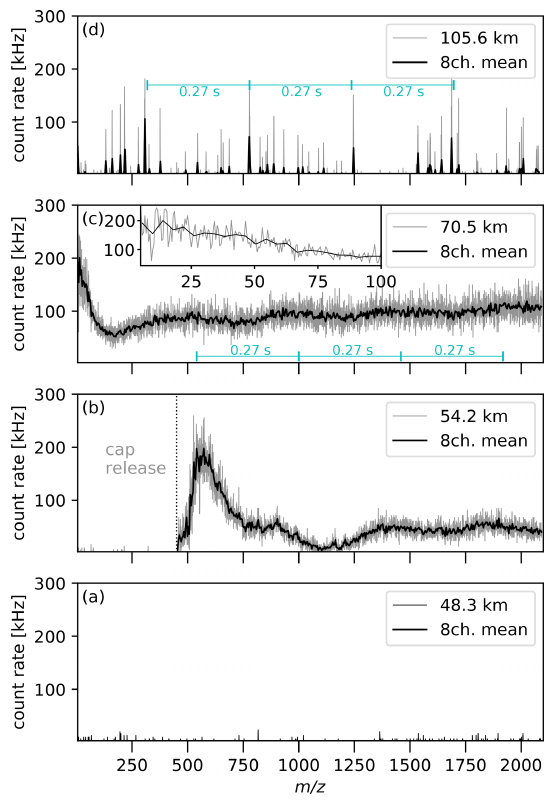
Figure 7. Negative-ion mass spectra in linear scales during ascent, at similar altitudes as the positive-ion mass spectra. In spectrum (a) the instrument is still sealed to the environment, while in spectra (b) , (c) and (d) natural ambient ions are present. The vertical resolution for spectrum (b) , (c) and (d) is 1431, 1245 and 688m